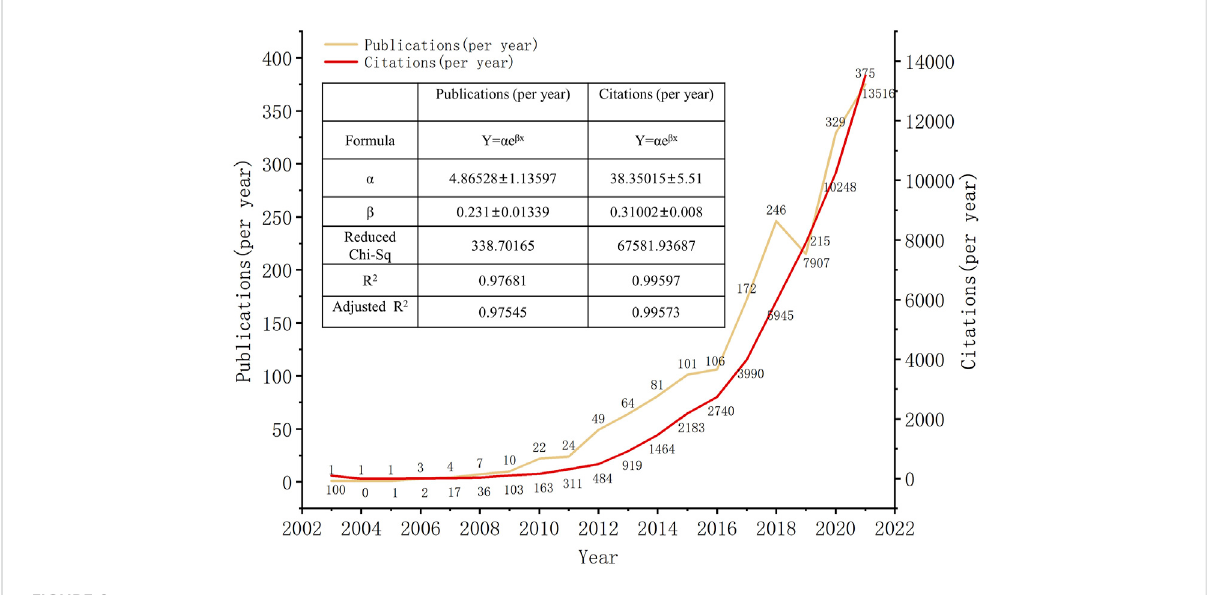
FIGURE 2 Publications and citations over the time